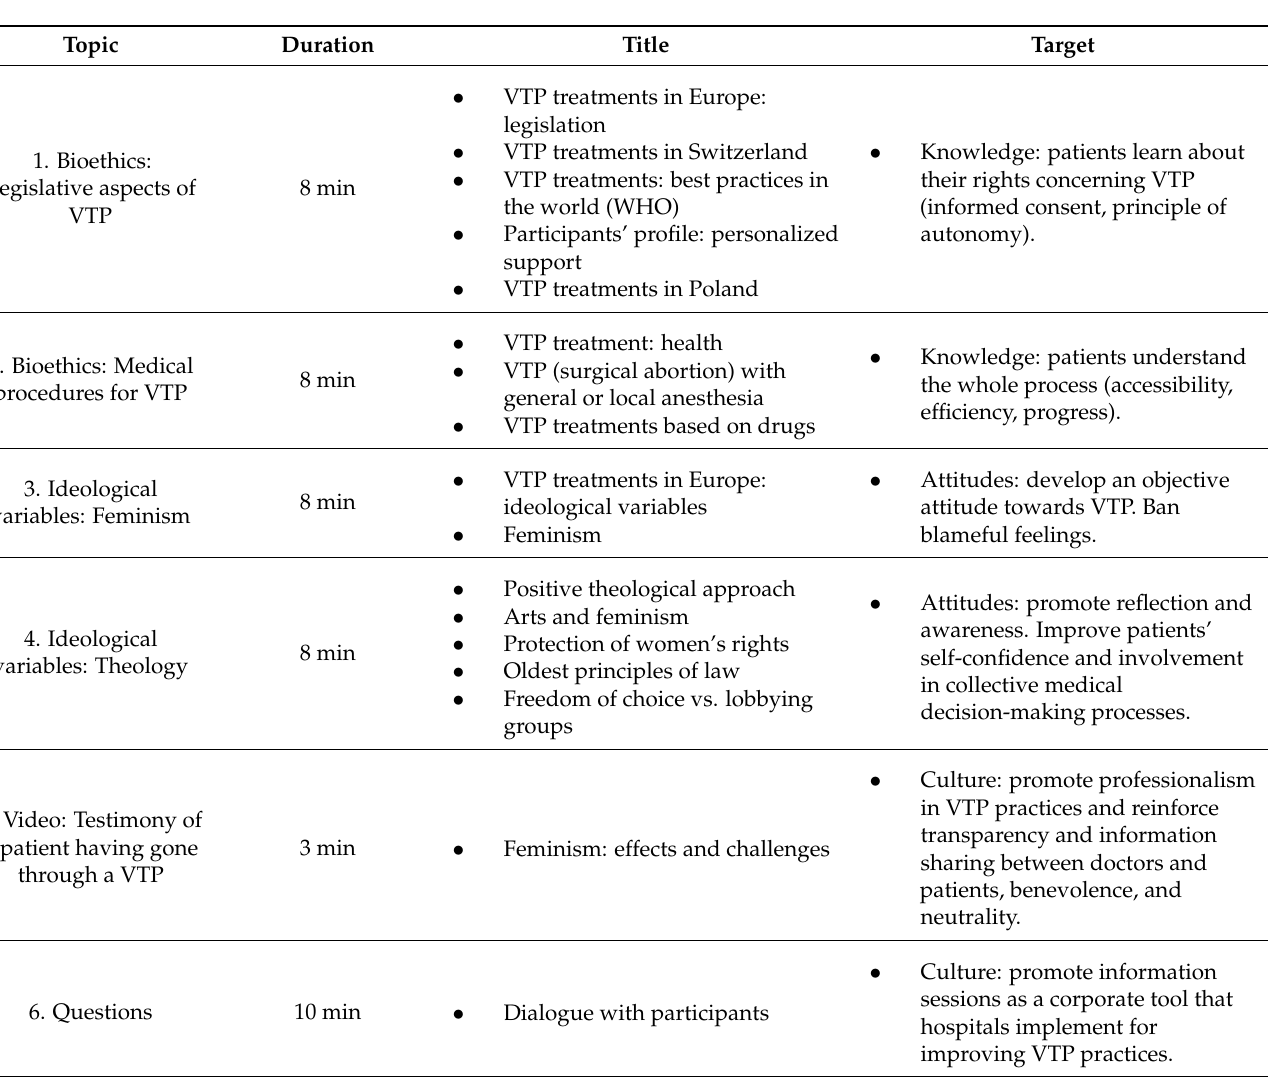
Table 3. Information session: main